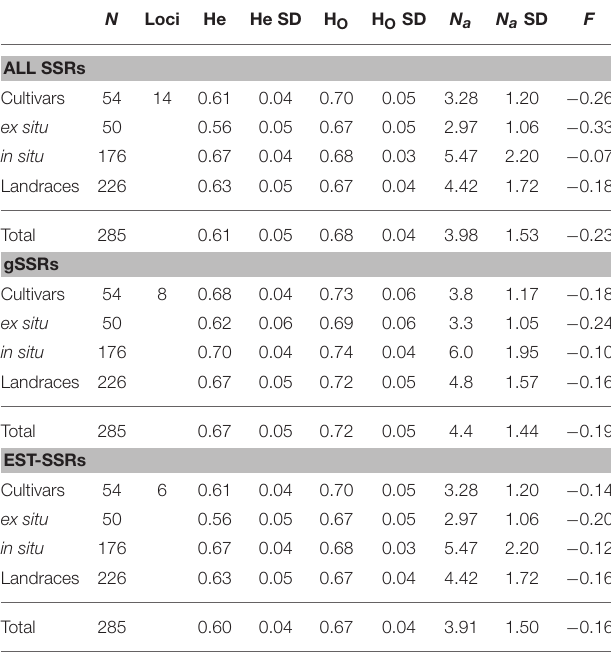
TABLE 3 | Genetic diversity analysis by cultivars and landraces (i.e., ex situ and in situ ).